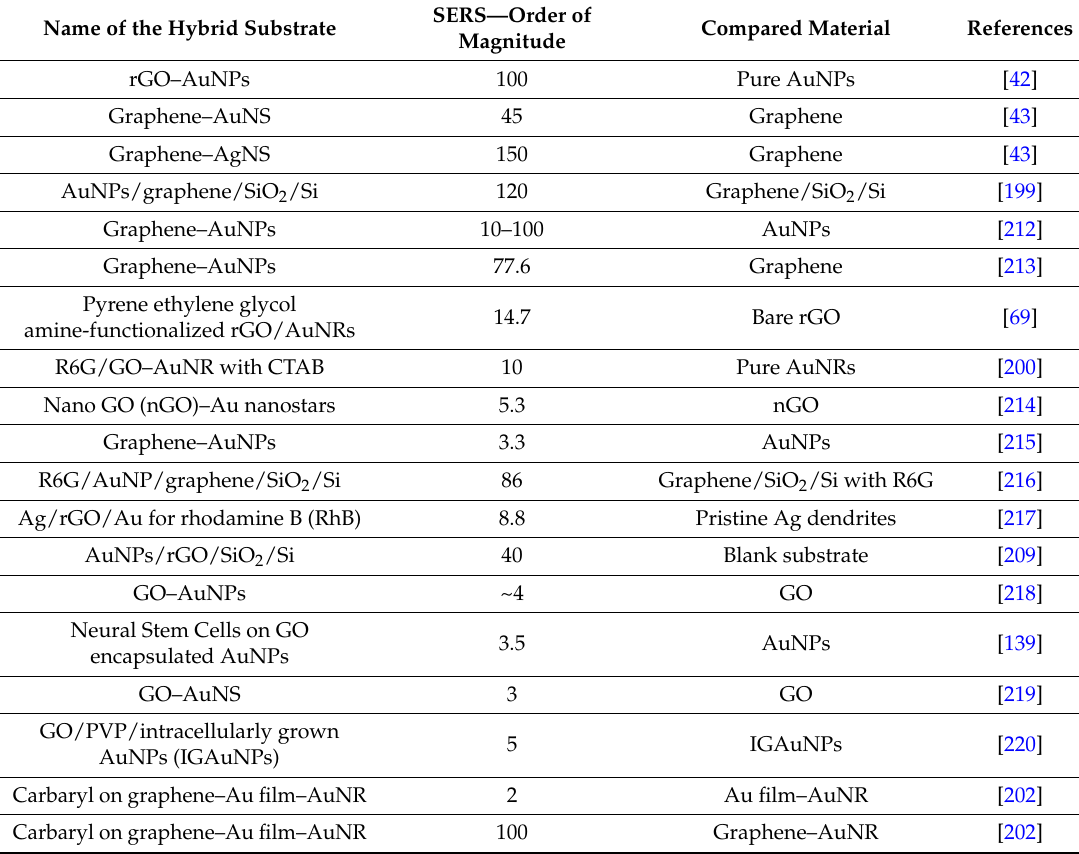
Table 7. SERS enhancement of the graphene–gold hybrid